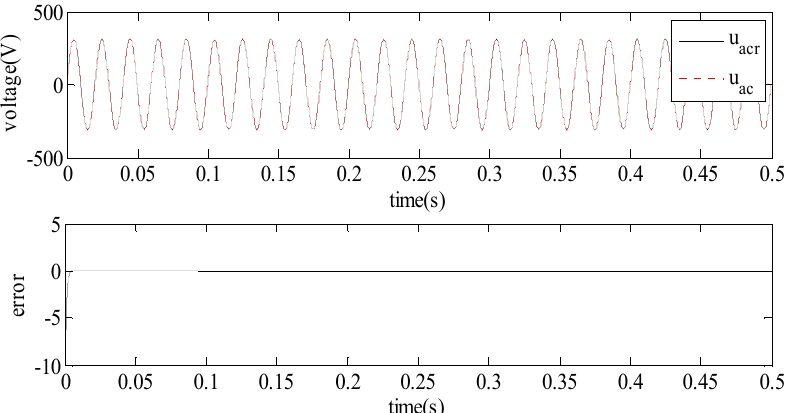
Figure 14. Tracking performance of the inverter using the AFSMC.